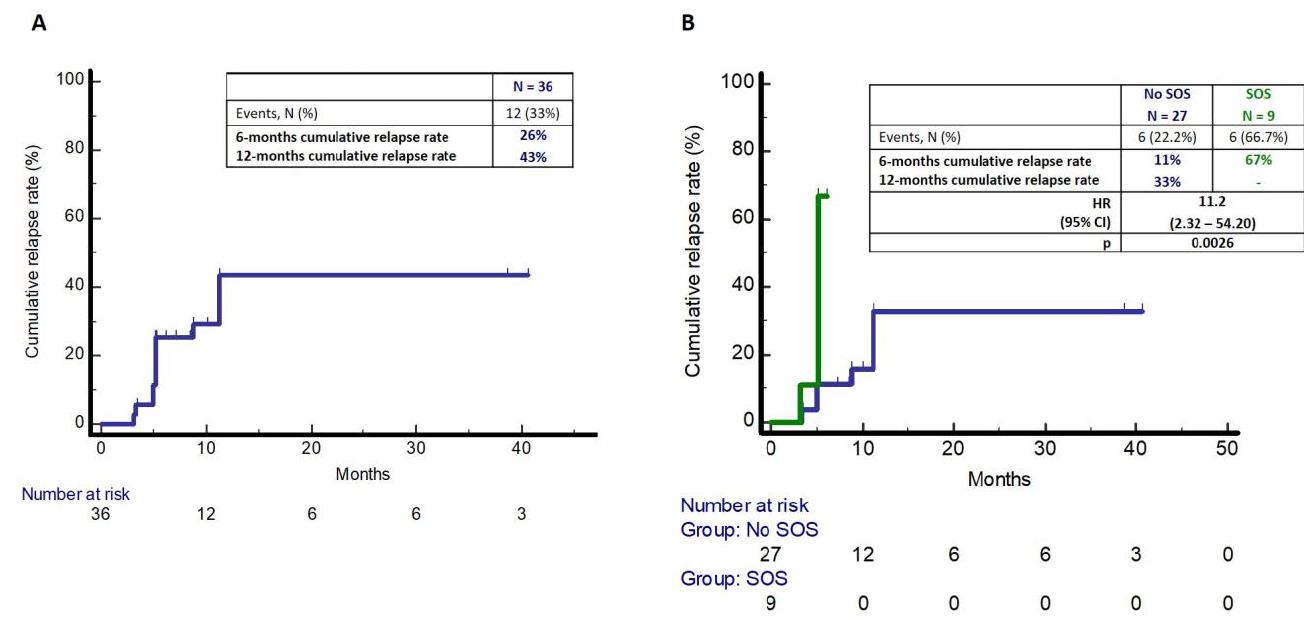
Figure 2. Cumulative relapse rate for DLM ( panel A ) and according to SOS ( panel B ).